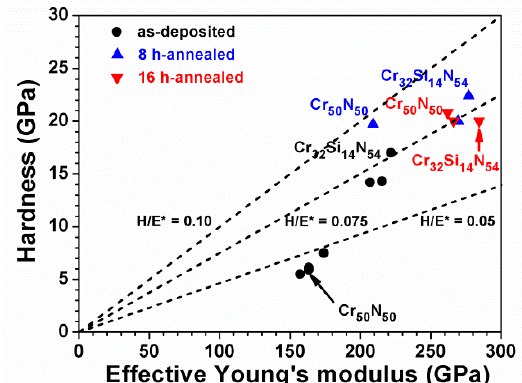
Figure 12. Relationship between hardness and effective Young’s modulus of the as-deposited and annealed Cr–Si–N coatings.